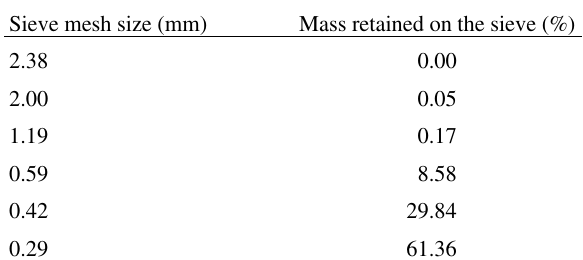
Table 1. Particle size distribution of the aggregate, according to the NBR 77211 code 7 .